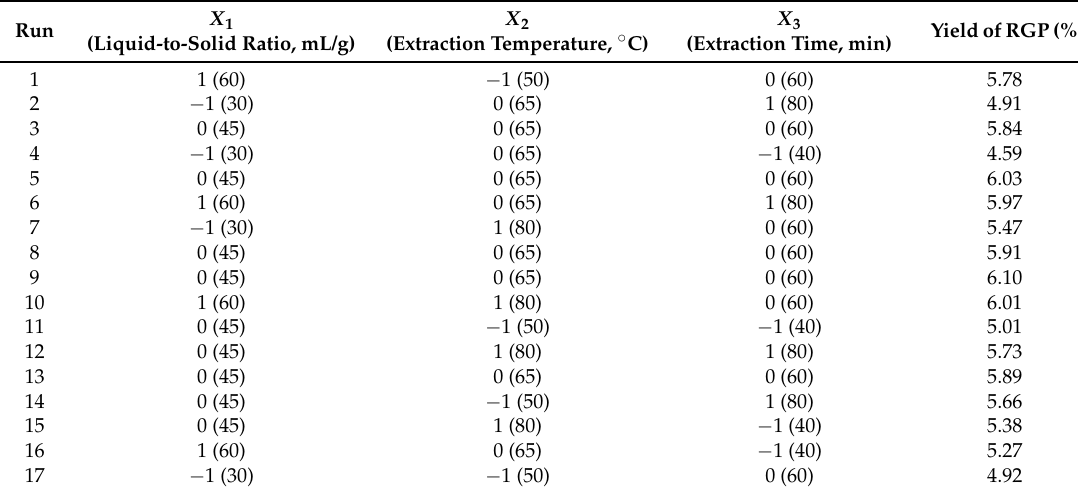
Table 1. The BBD matrix and response values for the extraction yield of Rhizoma gastrodiae Polysaccharide